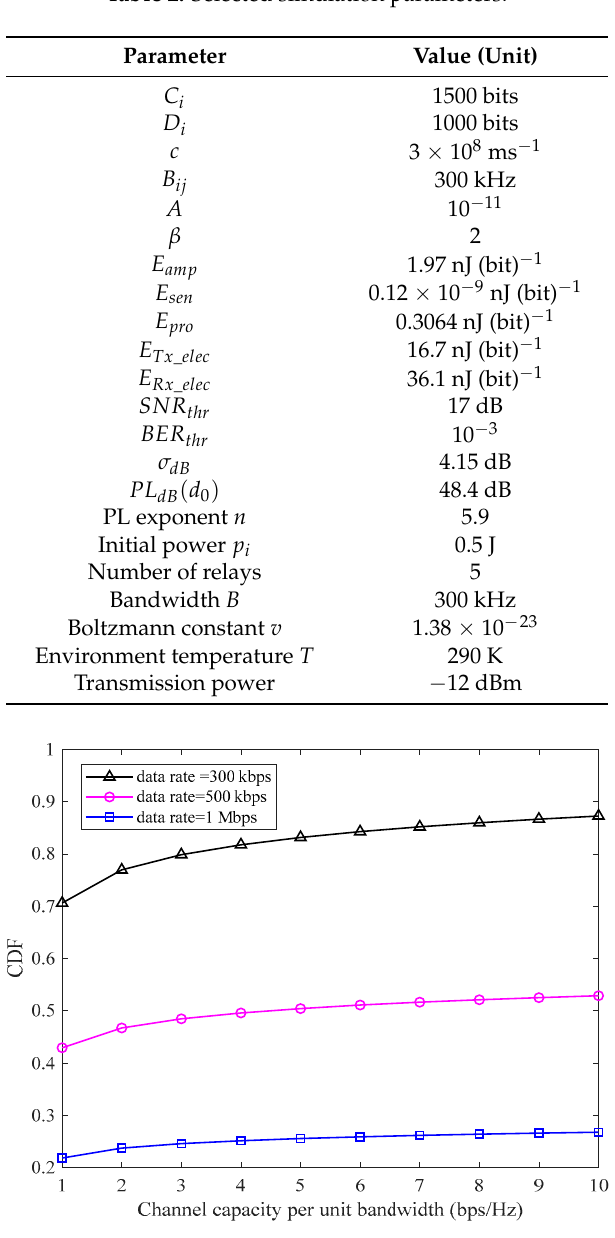
Figure 2. Cumulative distribution function (CDF) versus channel capacity per unit under on-body channel under different rates.